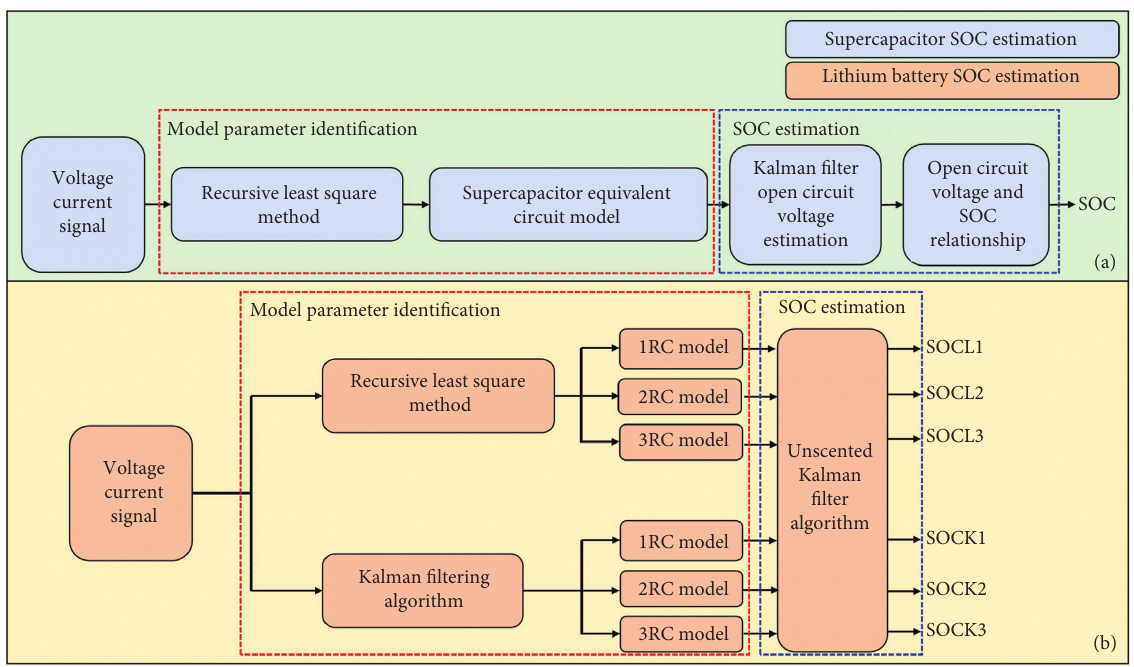
Figure 1: SOCestimationprocessforsupercapacitorsandlithiumbatteries.(a)FlowchartofSOCestimationofsupercapacitors;(b)flowchartofSOC estimation of lithium